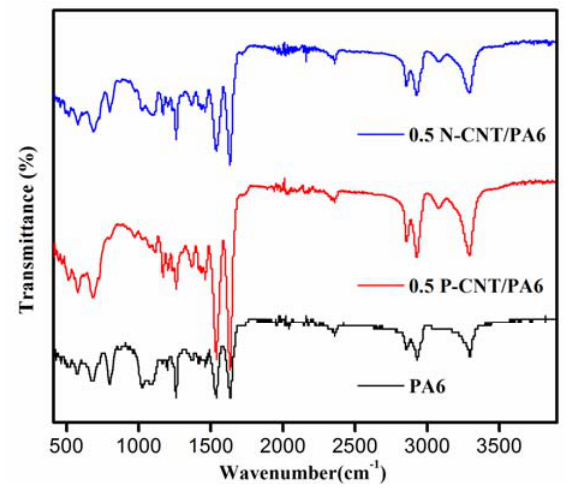
Figure 4. FTIR spectra of Neat and PA6/CNT composite samples.